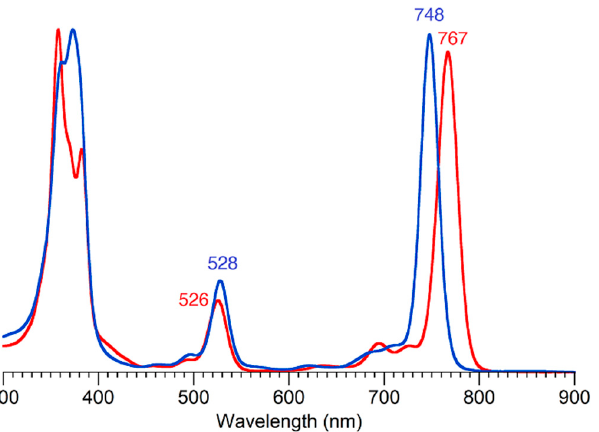
Figure 1. Absorption spectra of BC-1 (red) and MeOBC-1 (blue) in toluene at room temperature (normalized at the B band). (normalized at the B